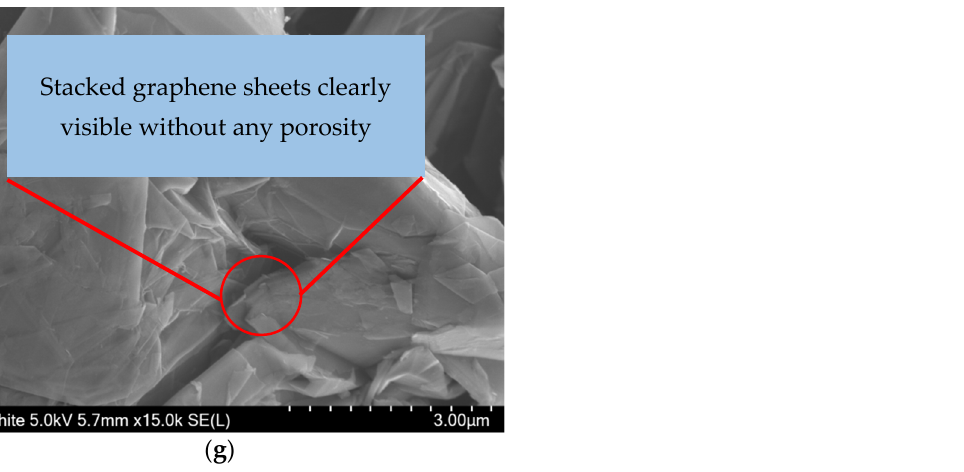
Figure 6. SEM images of CXG 500 ( a ), CXG 750 ( b ), CXG 1000 ( c ), CXG 1500 ( d ), CXG 2000 ( e ), CXG 2500 ( f ) and natural graphite powders ( g ) at 5 kV.